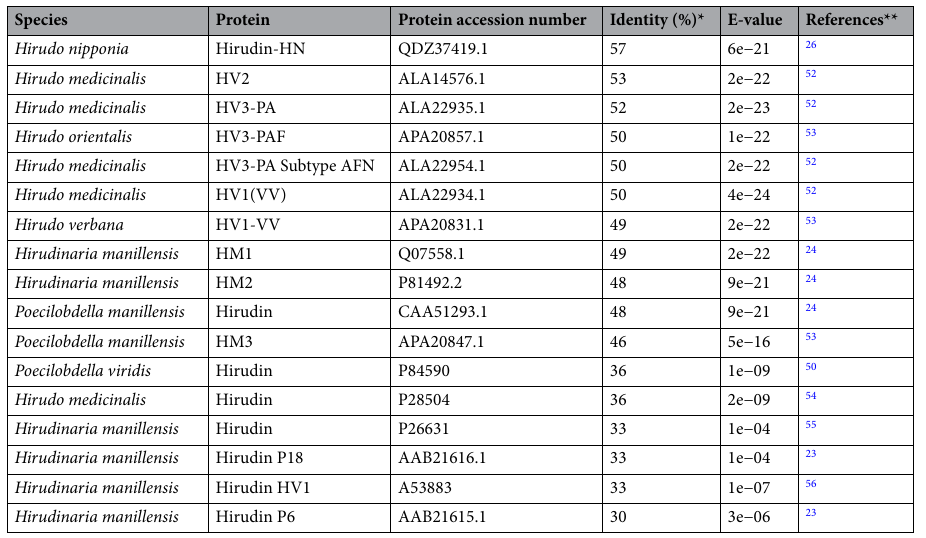
Table 2. Relevant species and their hirudin proteins. *Identity with hirudin was calculated using protein BLAST (protein vs. protein). **The initial report of the hirudin sequence of these organisms.